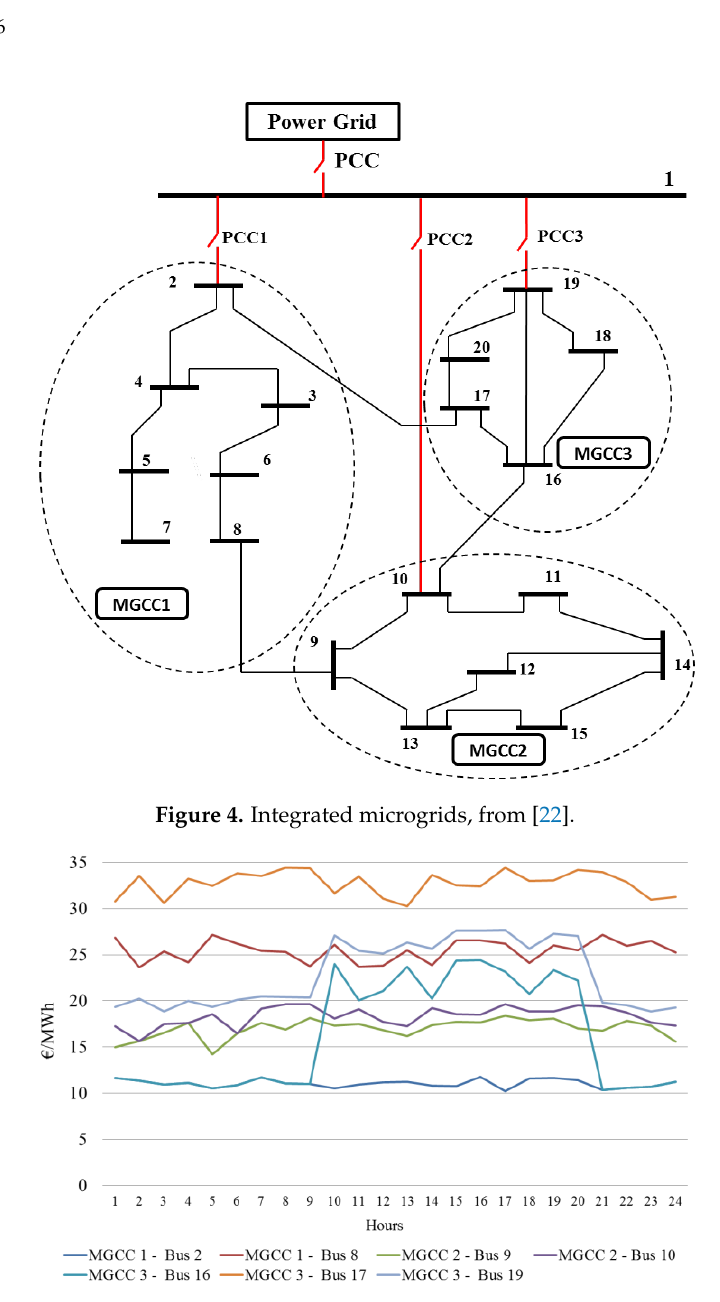
Figure 5. Hourly LMPs at connection buses (internal market clearing). Table 2. Overview of generation units in the considered integrated microgrids.